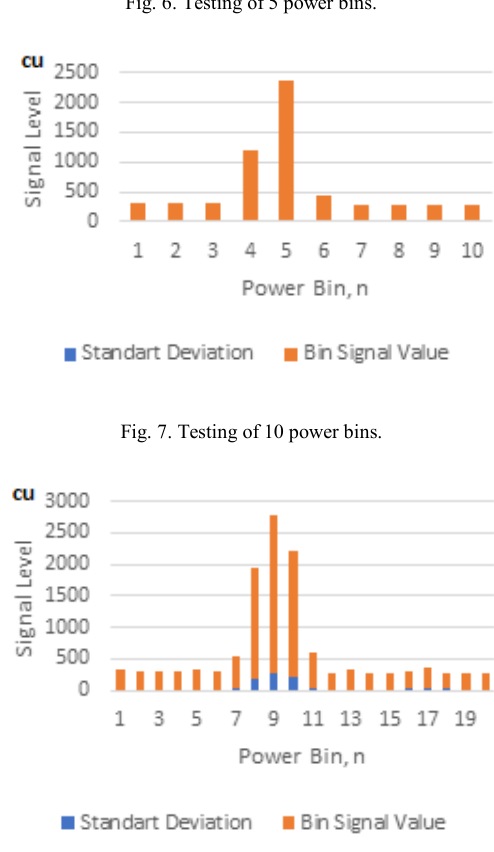
Fig. 6. Testing of 5 power bins.